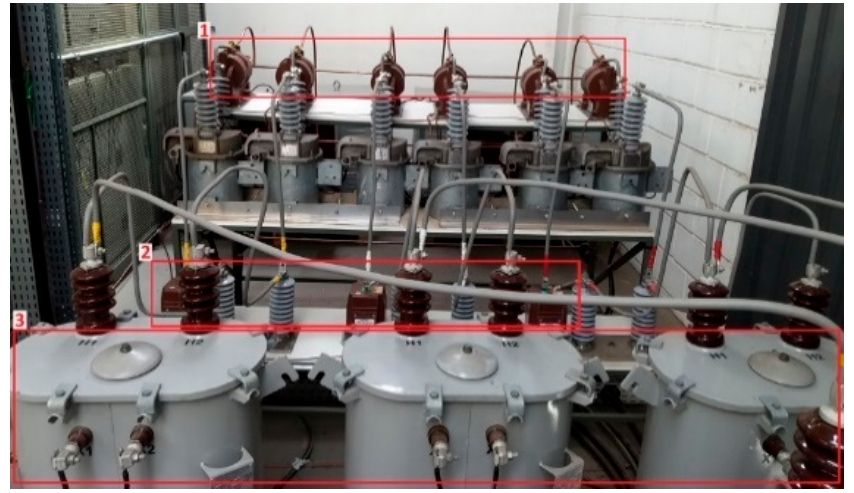
Figure 8. Medium voltage laboratory used in the tests.